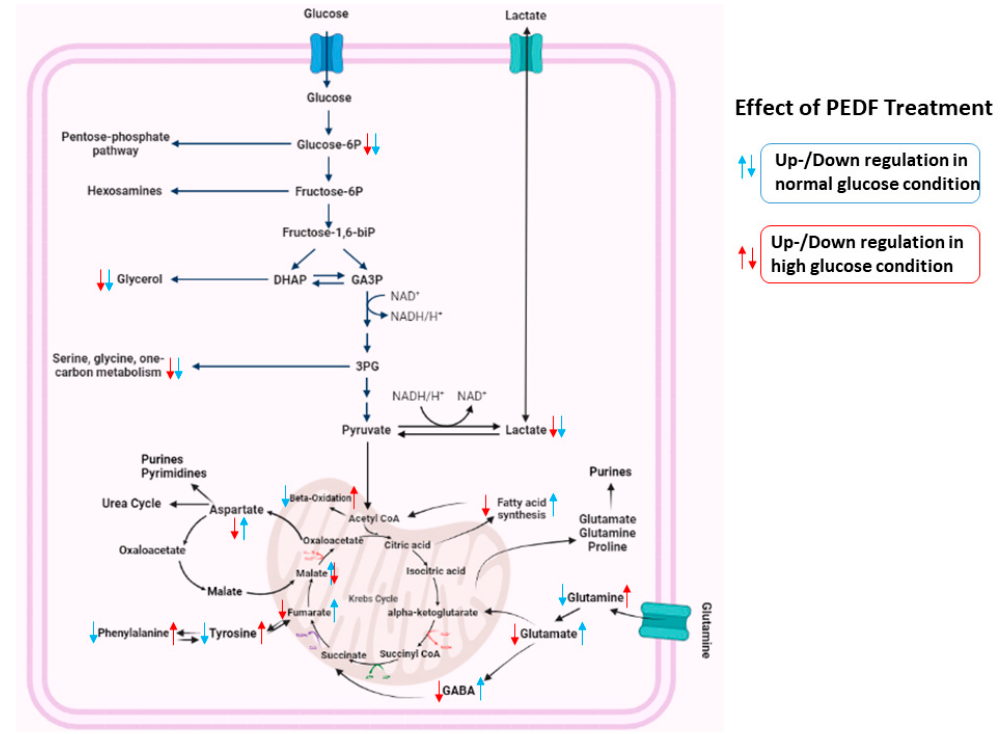
Figure 5. Schematic illustration of the metabolic reprogramming in TNBC cells under glycaemic conditions following PEDF treatment. The Warburg effect, amino acid metabolism, and TCA cycle are all shown as part of the metabolic changes during the PEDF treatment.